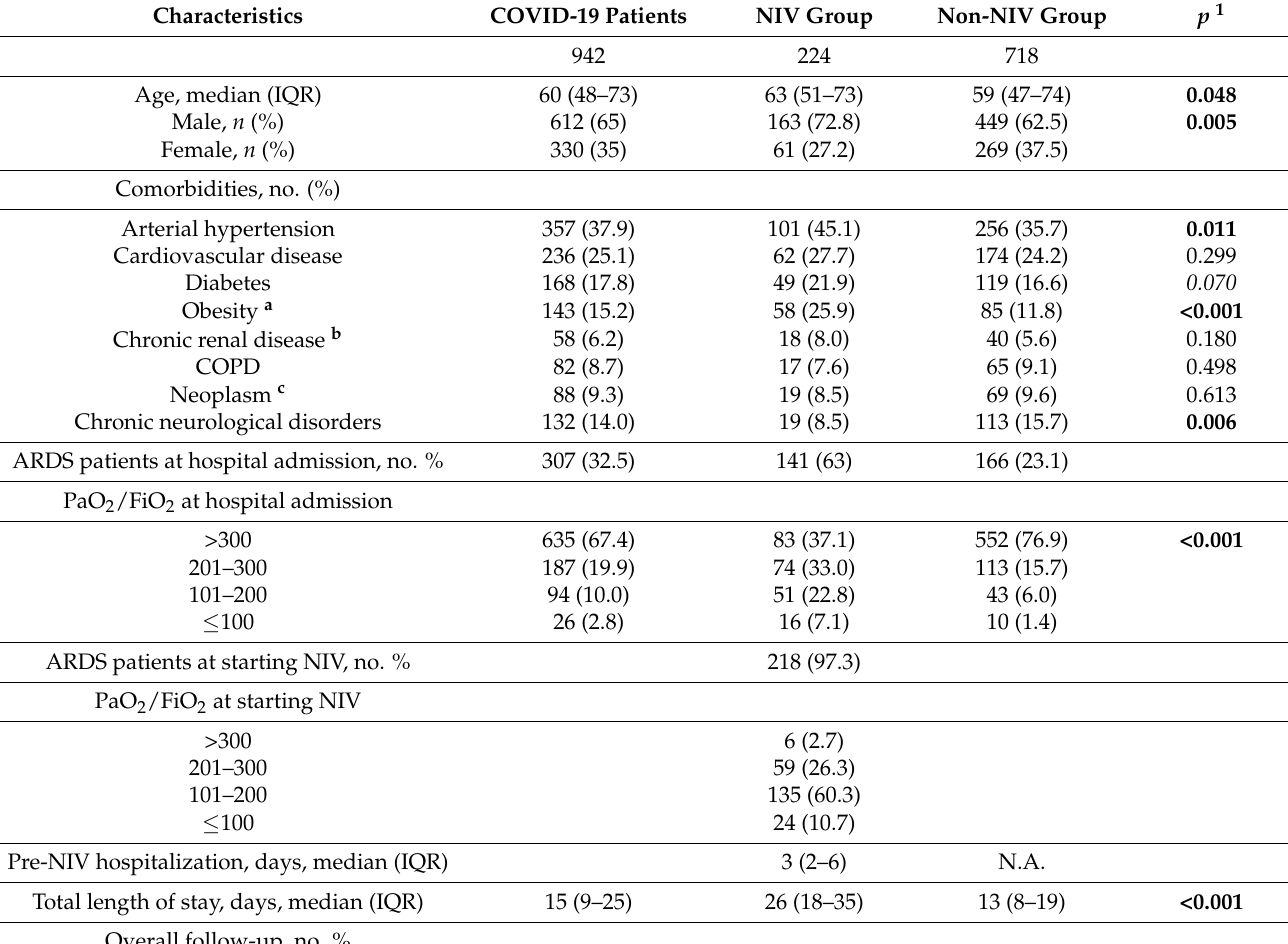
Table 1. Baseline demographics and clinical features of COVID-19 patients.